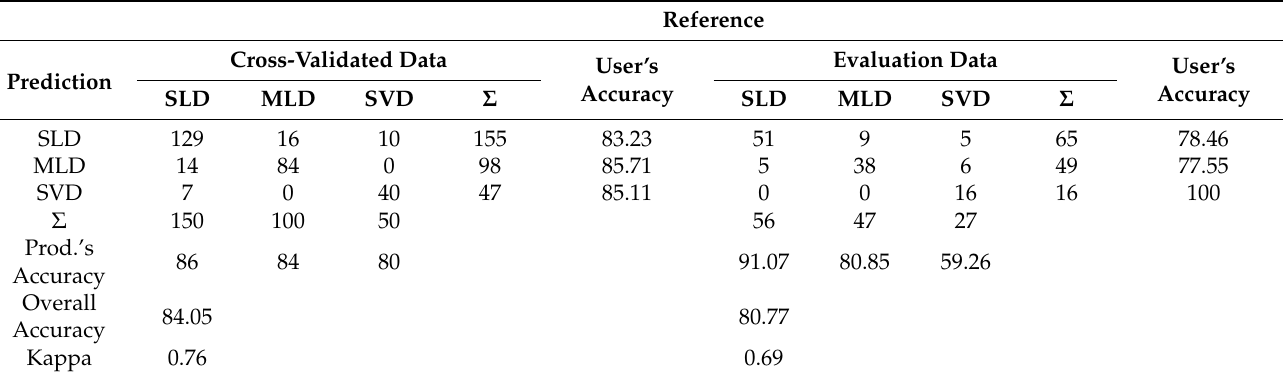
Table 6. 10-fold 5-times-repeated cross-validated confusion matrix of random forest classification of defoliation. SLD: Slight level of defoliation; MLD: Moderate level of defoliation; SVD: Severe level of defoliation.